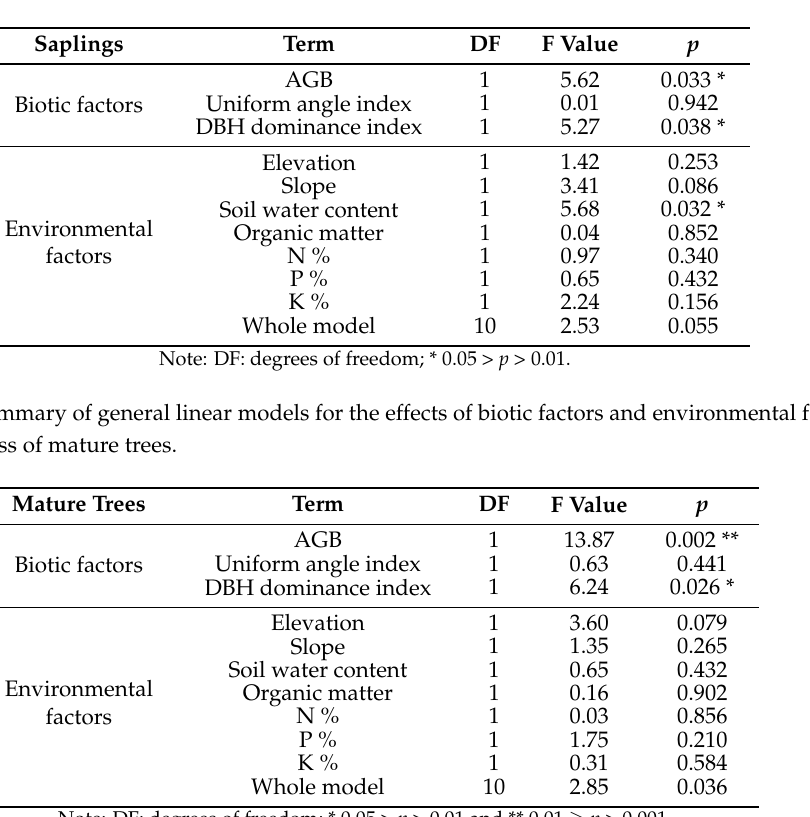
Table A1. Summary of general linear models for the effects of biotic factors and environmental factors on the richness of young trees.